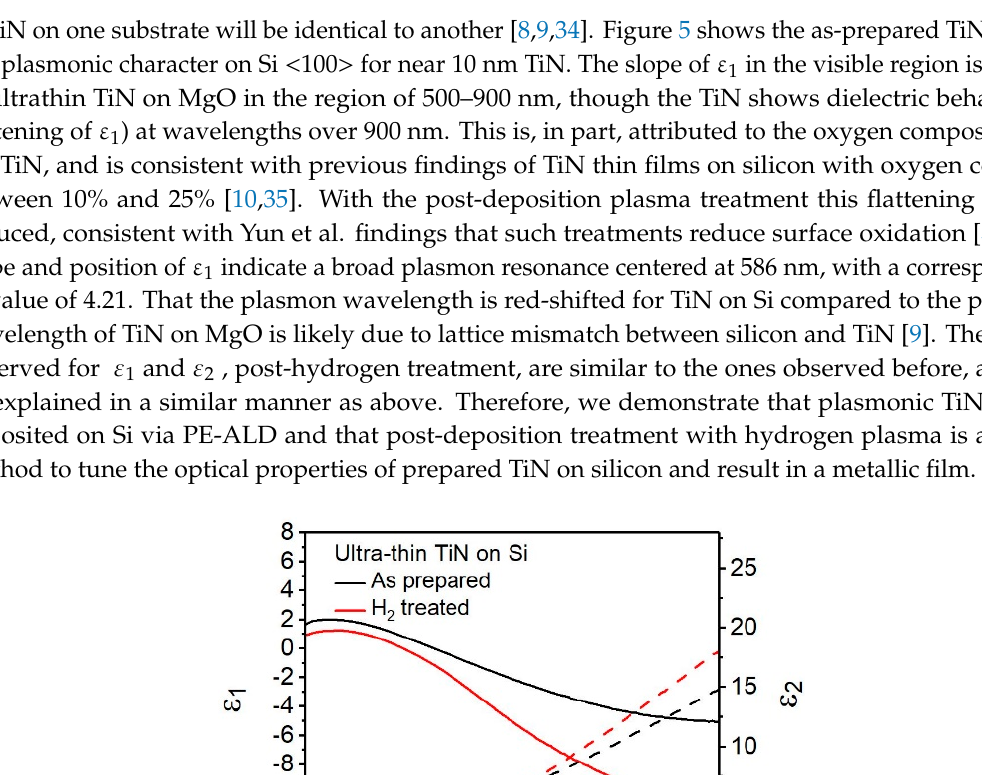
Table 1. Summary of plasmon resonances and ɛ 2 values for PE-ALD TiN on MgO and Si substrates. Film Thickness(nm)